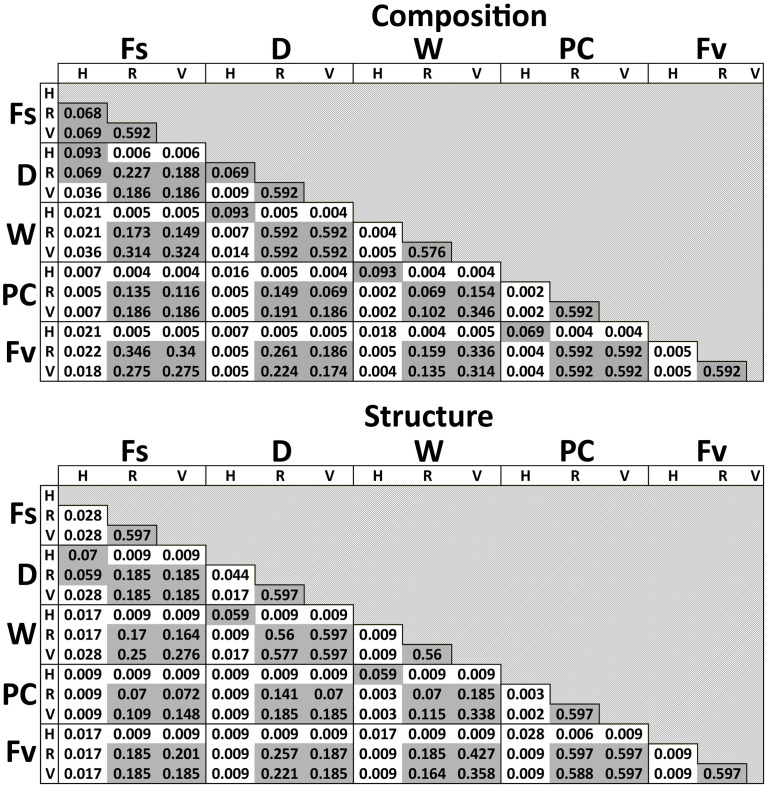
Adjusted p-values of pairwise comparisons of microbial composition and structure for the significant interaction term (Tissue:Treatment) over the three transplant treatments (Dry, Watered, Procedural control), unmanipulated Fucus vesiculosus and unmanipulated Fucus spiralis. Shaded values are not significant (p > 0.05).